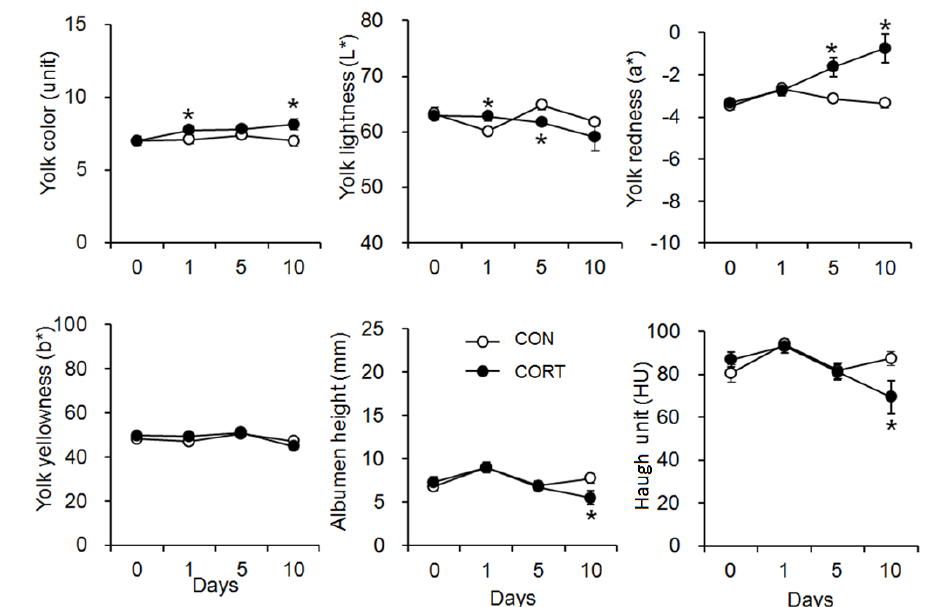
Figure 2. Effects of dietary corticosterone on yolk color, lightness (L*), redness (a*), yellowness (b*), albumin height, and Haugh unit of eggs in laying hens. The birds were provided for 14 days with either control (CON) or experimental diet (CORT) containing corticosterone at 30 mg/kg diet. * p<0.05. Data show means±standard error of the mean (n =